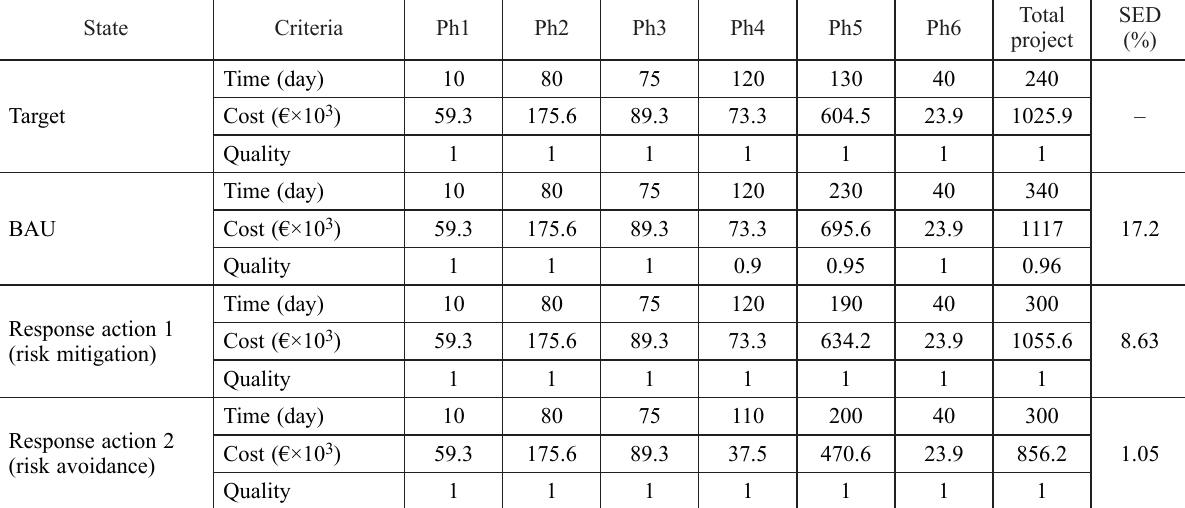
Table 5. SED index calculations for the BAU and two response actions for the risk event of “increase in tar